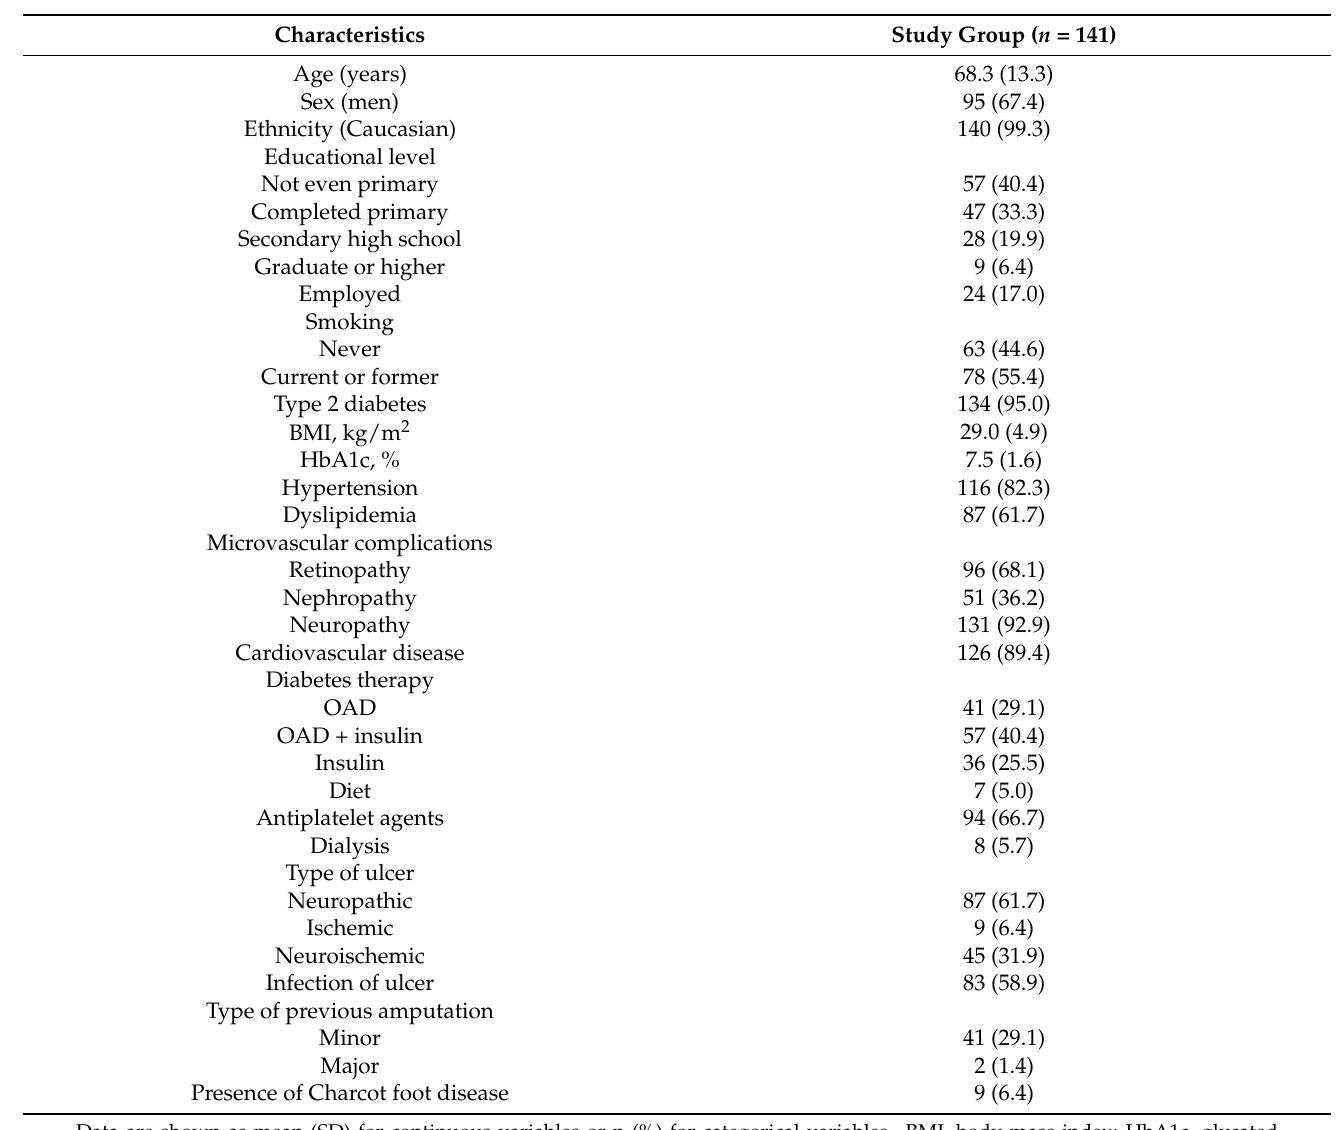
Table 1. Baseline clinical and sociodemographic characteristics of the study